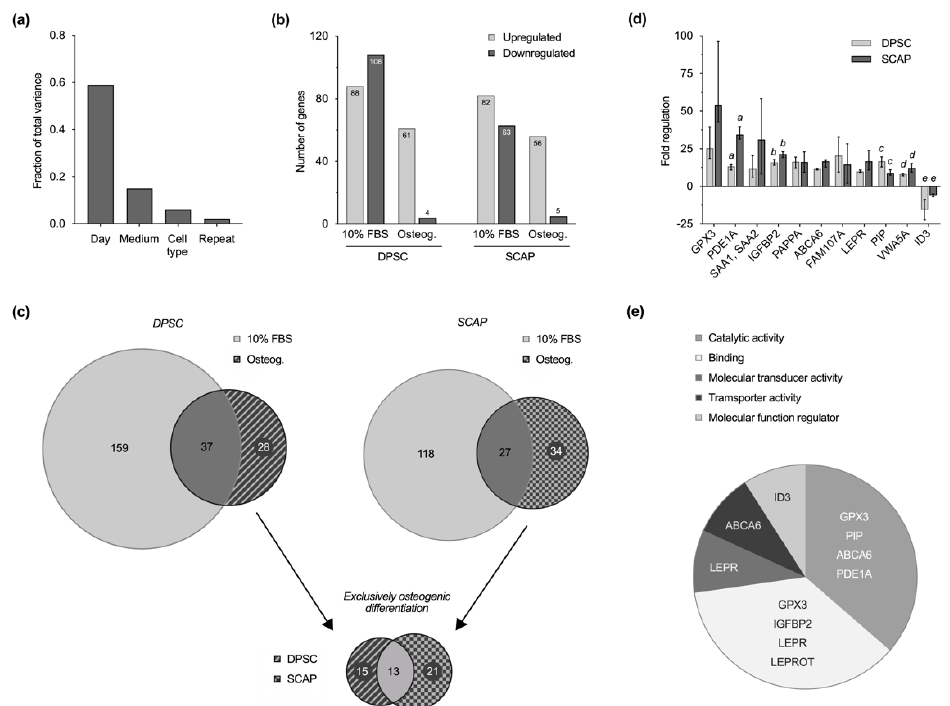
Figure 4. Transcriptome analysis. ( a ) Fraction of total variance highlights the impact of culture time on gene regulation among other culture parameters. ( b ) Number of up- and downregulated genes within the investigated groups on day 14 compared to day 1. Similarities between dental pulp stem cells (DPSC) and stem cells from the apical papilla (SCAP) are visible in standard cell culture and osteogenic differentiation. Fewer genes were regulated during differentiation and most of them were upregulated on day 14 of cell culture. ( c ) VENN diagrams for each cell type reveal subsets of genes that are specifically regulated in standard culture or osteogenic differentiation. Comparison of exclusively regulated genes during osteogenic differentiation of DPSC (28) and SCAP (34) enables the identification of 13 key genes that play a key role in osteogenesis of both cell types. ( d ) Microarray validation by quantitative reverse transcription PCR (qRT-PCR). Regulation of selected genes in DPSC and SCAP during induced differentiation at day 14 as median values and 25–75% percentiles. Regulations of all genes were statistically significant compared to baseline ( p ≤ 0.0236), whereas equal lower-case letters for each gene indicate pairs (DPSC and SCAP) with significant differences ( p ≤ 0.05). ( e ) PANTHER classification of 13 key genes according to molecular function. Genes with